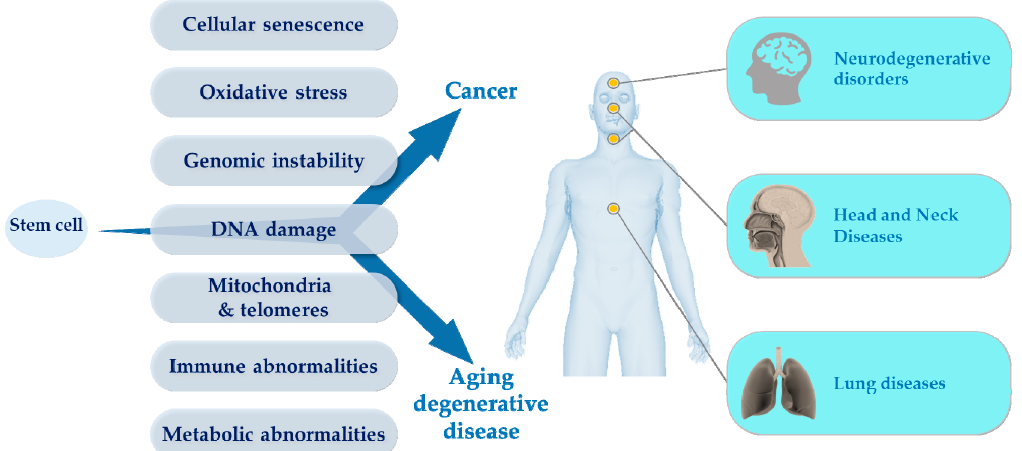
Figure 1. Common mechanisms that drive degenerative diseases and cancer. OncoAge is dedicated to three major pathologies: thoracic diseases (tumoral or non-tumoral), head and neck and thyroid pathologies, and neuromuscular degenerative disorders.